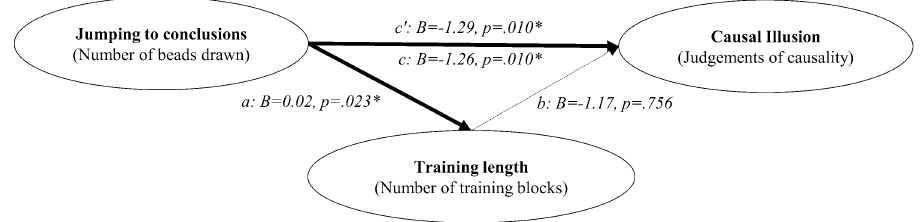
Figure 6. Path model in Study 1. The letters a, b, c, and c’ depict the paths between the three variables, which are weighted by the regression coefficients. Significant coefficients ( p < .05) are indicated with one asterisk. The total effect (path c) can be decomposed into two components, the direct effect and the indirect effect. Paths a and b represent the indirect effect that operates via the mediator, the number of training blocks on the contingency learning task. Path c’ represents the direct effect of JtC scores on the causal judgements, that is, the amount of predictive power left after the mediational effect of training length has been partialed